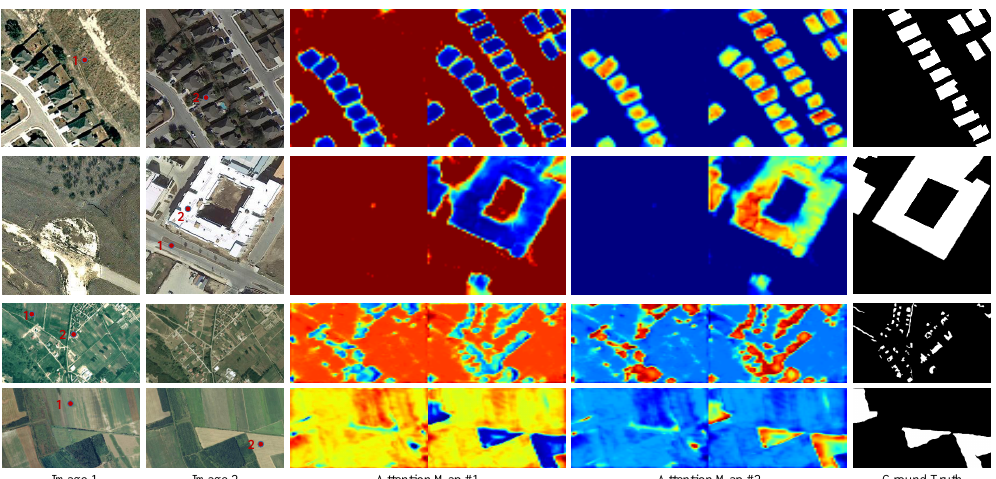
Visualization of attention maps on LEVIR-CD and SZTAKI test sets. Each row represents one sample (image 1, image 2 and ground truth) and the visualized attention maps corresponding to the points marked on the input bitemporal images. For example, in attention map #1, it shows the attention of point #1 on all the pixels in the bitemporal images. Red denotes higher attention, while blue indicates lower